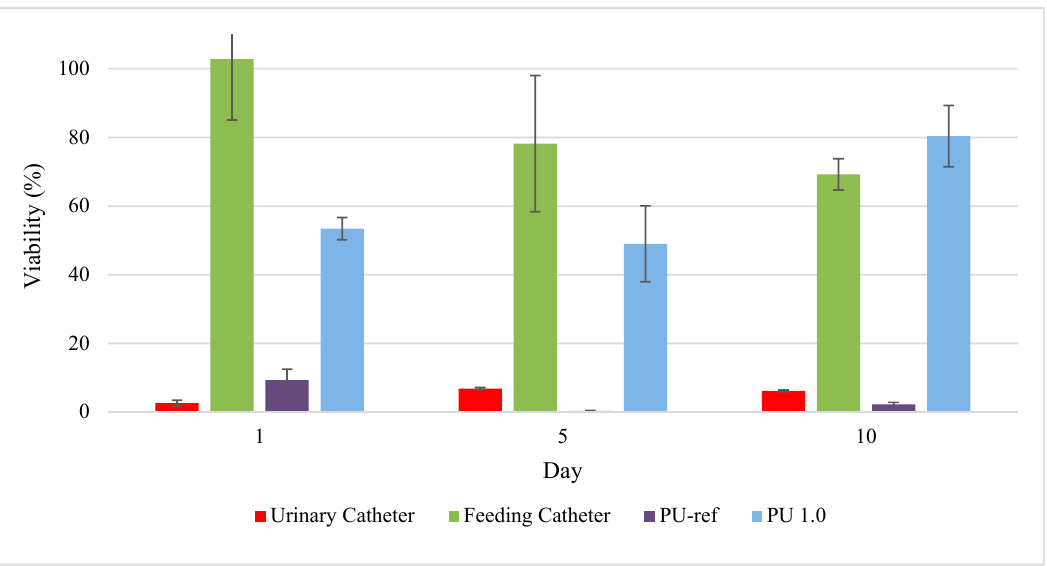
Figure 11. Cell viability of urinary catheter, feeding catheter, PU-ref and PU 1.0 for 1, 5 and 10 days (Mean ± SD, n = 9) PU-ref was prepared by reacting PCL-diol and PEG with IPDI at isocyanate index of 1.0, while PU 1.0 was prepared by reacting palm oil-based polyester polyol with IPDI at isocyanate index of 1.0.